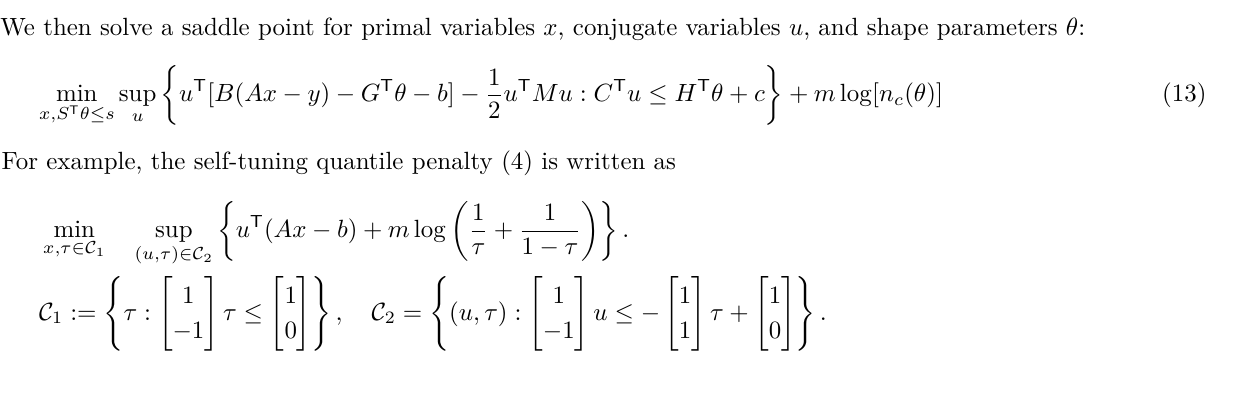
Algorithm 4 Interior point method for QS with θ